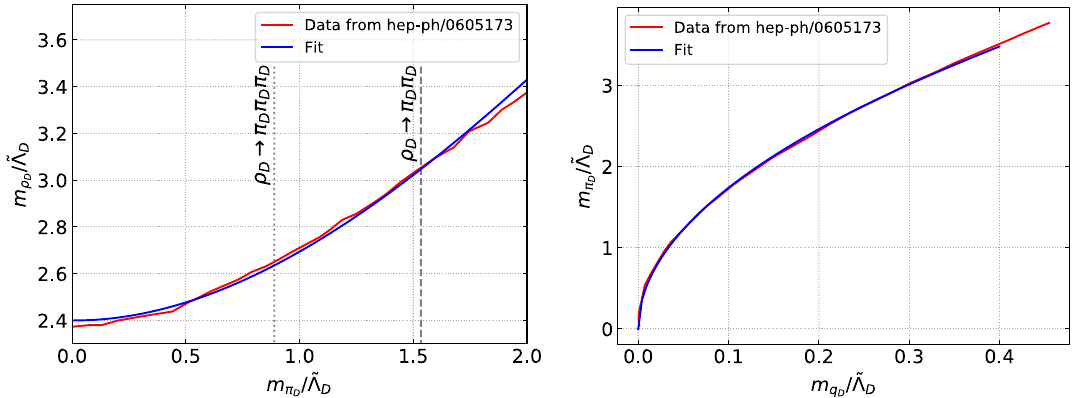
Fig. 22 Fits given in Eq. 14 for the ρ D mass (left) and π D mass (right) to results from lattice simulations [185]. The left panel also indicates the kinematic thresholds for ρ D to decay to π D π D and π D π D π